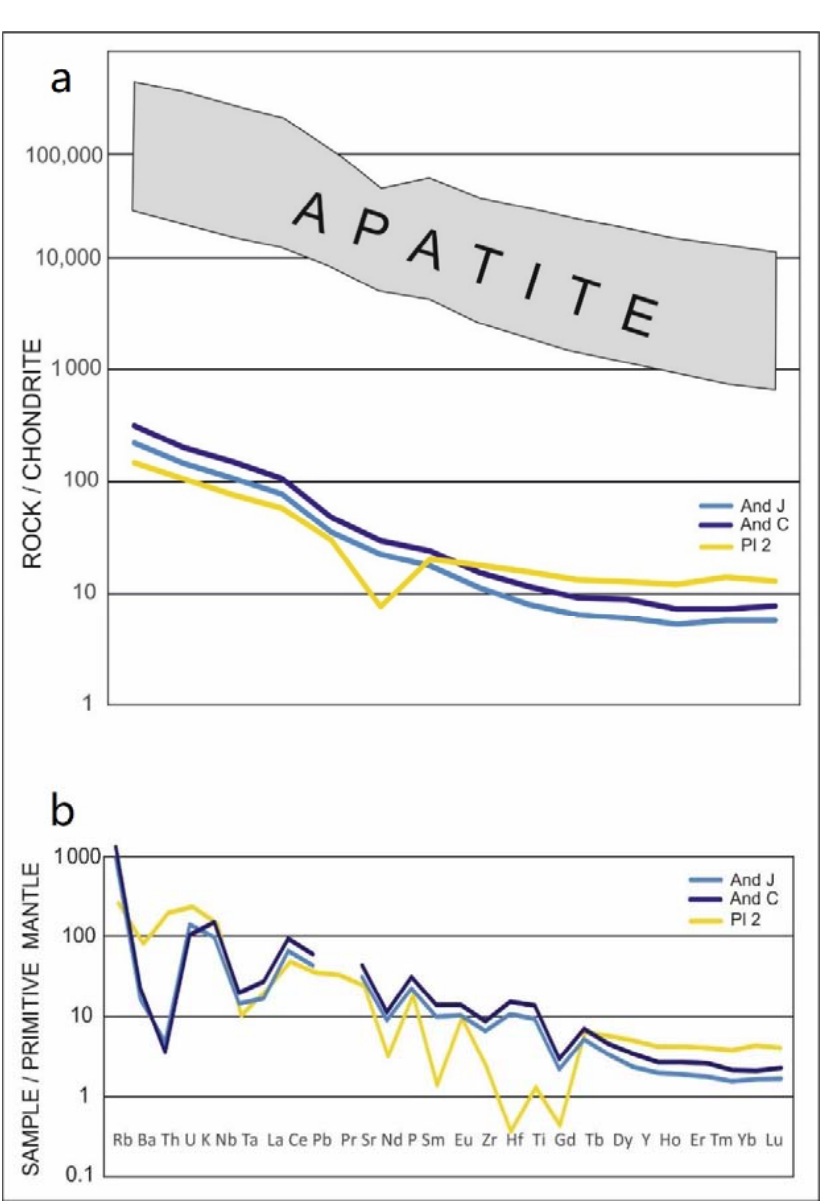
Figure 4. ( a ) Chondrite (C1)-normalized REE patterns of the microgranitoid (Pl 2) and andesite (And) from Pluskawka, with apatite from PL 2 (grey area); ( b ) primitive mantle normalized multi-element patterns of the analysed PL 2 and And exotic blocks from Pluskawka stream. Normalization values after McDonough and Sun [20]. Table 1. Representative microprobe analyses of biotite and muscovite with their crystal-chemical formulas recalculated for 22 O 2 − .